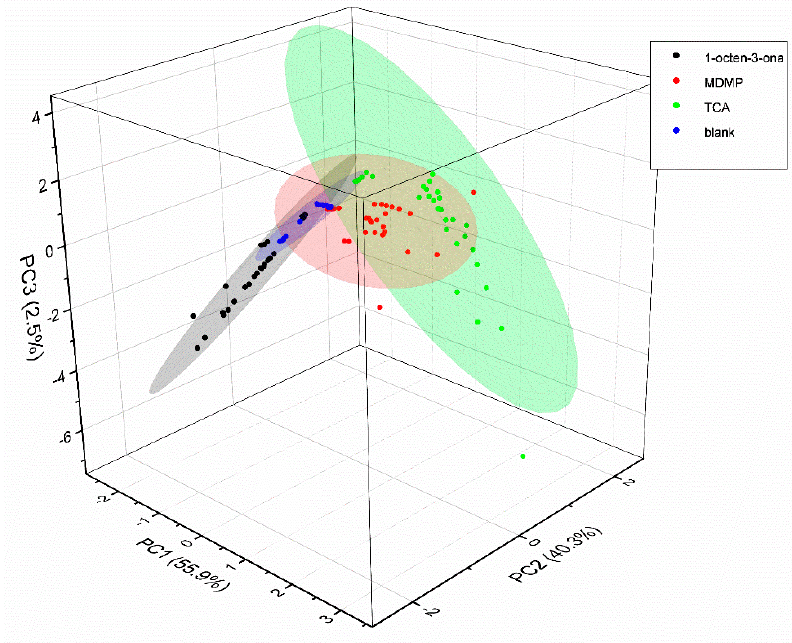
Figure 6. PCA score plot for all measurements.